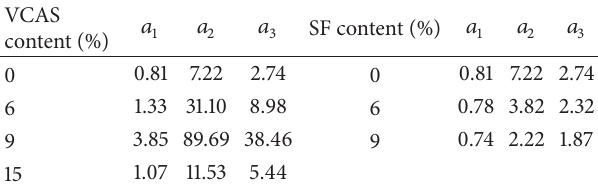
Table 9: 𝑎 1 , 𝑎 2 , and 𝑎 3 are fitting parameters for degree of hydration of VCAS and SF (Neithalath’s study